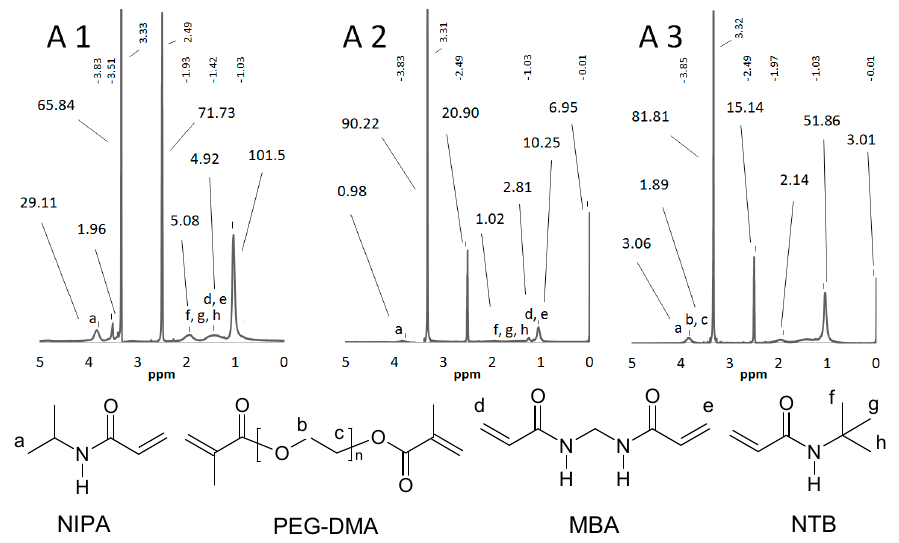
Figure 1. 1 H-NMR spectra of A1–A3. The shifts (at the top of the spectra, small digits) and respective integrals (below the shifts, bigger digits) are presented above the spectral line.